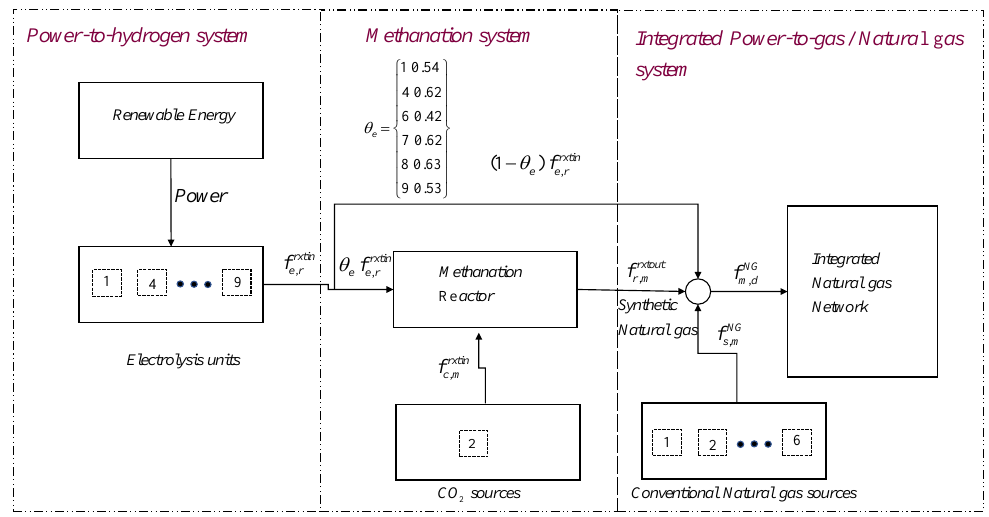
Figure 7. Process description for combined methanation and hydrogen injection into natural gas networks (Case B).